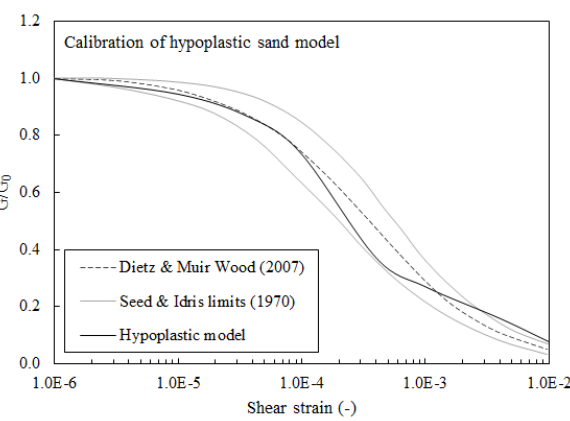
against shear strain. 0